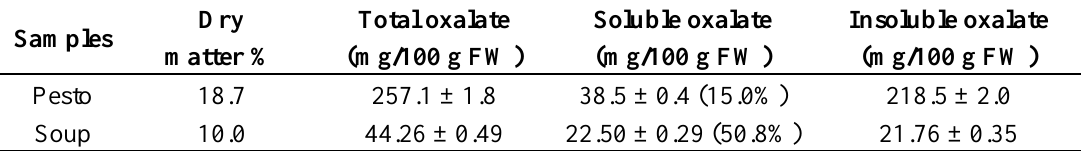
Table 4. The oxalate contents in Good-King-Henry pesto sauce and soup (mg/100 g FW ± SE). Values in brackets % soluble oxalate of total